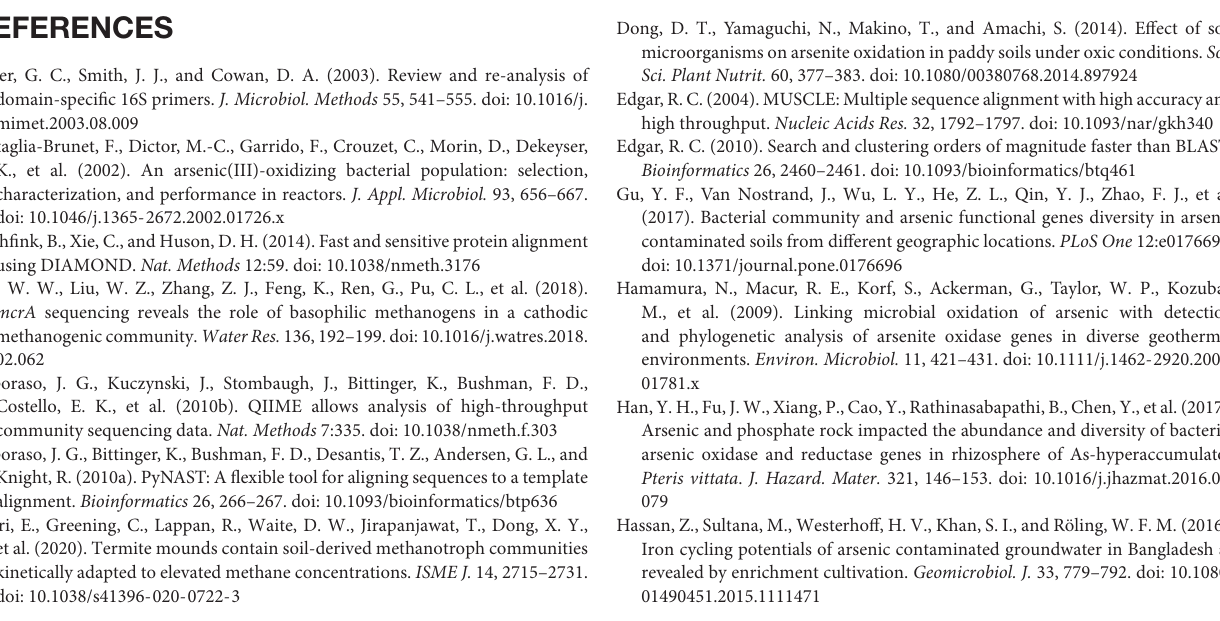
Supplementary Figure 1 | Phylogenetics of the 67 aioA genes used for the primer design, and the hits (a pair matched the same sequence with a maximum of two mismatches and alignment length larger than 16 nt) of the two primer pair matches) of the three primer pairs to the 67 aioA gene sequences. The solid square represents a hit of the primer pair to the corresponding aioA gene sequences, whereas the hollow square represents the primer pair could not match to the aioA gene sequences. The order of the squares in each aioA sequence are shown as1109F/1548R, M1-2F/M3-2R, and deg1F/deg1R. Sequences of arrA from Shewanella sp. ANA and Bacillus selenitireducens MLS10 functioned as outgroups in building the phylogenetic tree. Supplementary Figure 2 | Neighbor-joining tree of the 20 most abundant OTUs in the library of the aioA -1109F/1548R. The average relative abundances (%) for the paddy soil and sediment samples are given to the right of each OTU. The scale bar indicates the sequence dissimilarity between the nodes. Supplementary Table 1 | Information of arsenite oxidase and the corresponding genes used in the primer design. Supplementary Table 2 | Geochemistry of the paddy soils and sediments used for the aioA genes high-throughput amplicon sequencing. Supplementary Table 3 | Barcoding primer sequences for the amplicon sequencing on the Illumina Hiseq platform. Supplementary Table 4 | The amplicon sequencing information and alpha diversity index of the aioA genes on the Illumina Hiseq platform using the two newly designed primer pairs. Supplementary Table 5 | The difference in α -diversity of the paddy soil and sediment samples in the libraries of 1109F/1548R. Supplementary Table 6 | Phylogenetics of the aioA OTUs (with relative abundance > 1%) with their closest